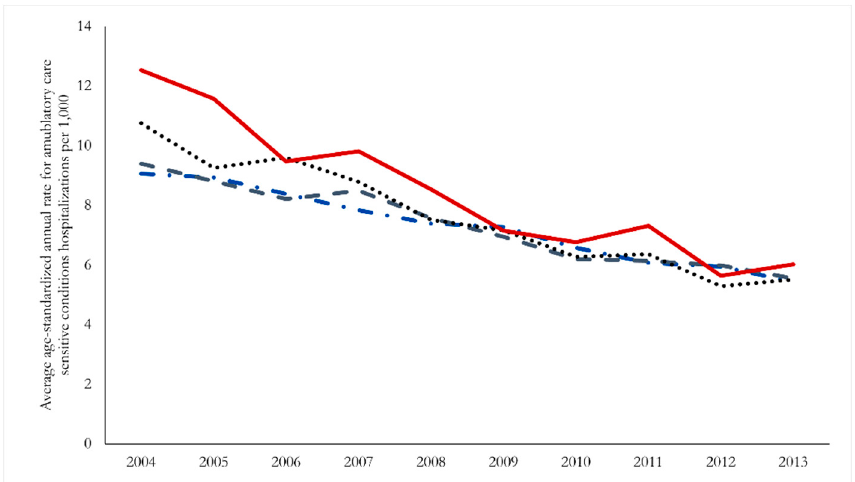
Figure 3. Trends in age-standardized annual rates of hospitalizations for ambulatory care sensitive conditions among those 74 years of age and younger in New Brunswick, 2004–2013 according to community peer groupings. Dash/Dot—major cities, Dashes—smaller urban areas, dots—towns, solid line—rural areas.